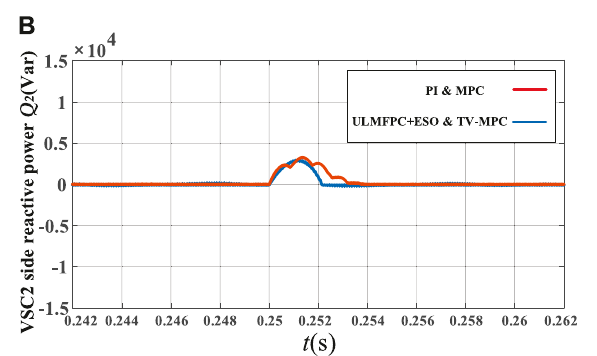
FIGURE 13 (A) Change of the current waveform of PI & TV-MPC. (B) Change of the current waveform of ULMFPC with ESO & TV-MPC.